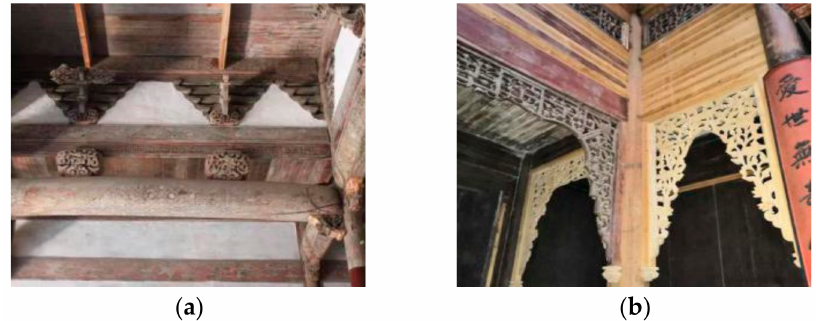
Figure 2. The repaired Huizhou-style buildings of timber components in the ( a ) JiXi Confucian Temple (which had been historically repaired and restored three times during Qing dynasty) and ( b ) Chengzhi Tang in Hong Village HuangShan, Anhui